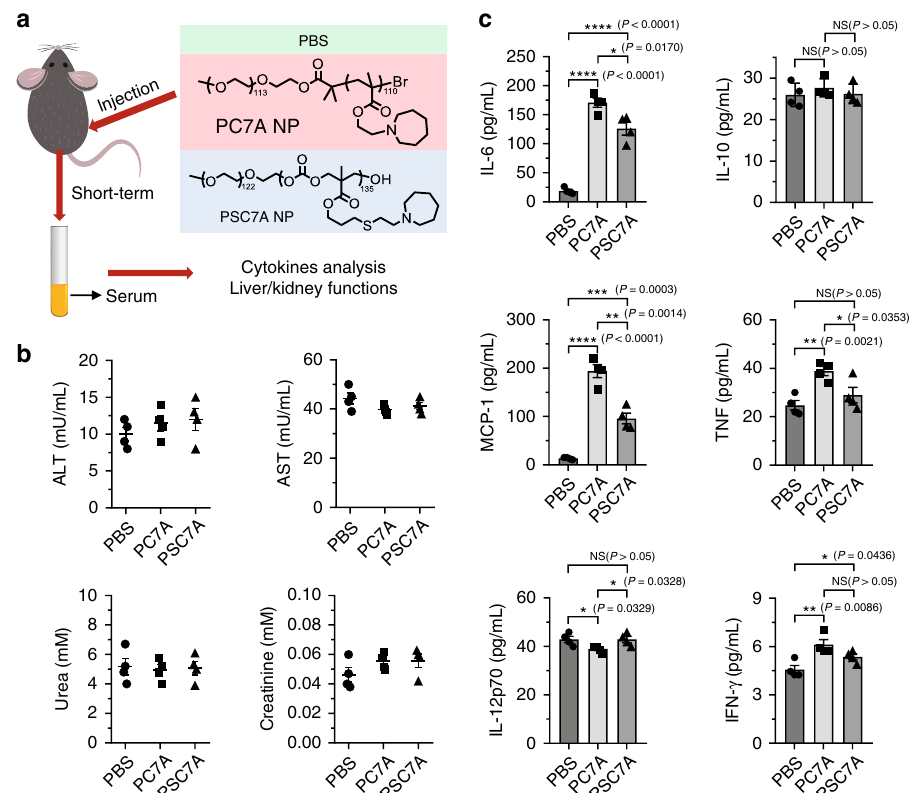
Fig. 6 Short-term safety evaluation of degradable PSC7A NP and non-degradable PC7A NP. a C57BL/6 mice were subcutaneously injected with PBS, 300 μ g PSC7A NP, or 300 μ g PC7A NP on the right fl ank. b Serum concentrations of alanine aminotransferase (ALT), aspartate aminotransferase (AST), urea, and creatinine levels were quantitatively measured by Abcam TM Assay Kit 24h after injection. n = 4 biologically independent mouse samples in each group. Data are presented as means± s.e.m. c Serum concentrations of interleukin-6 (IL-6), interleukin-10 (IL-10), monocyte chemoattractant protein-1 (MCP-1), interferon- γ (IFN- γ ), tumor necrosis factor (TNF), and interleukin-12p70 (IL-12p70) protein levels were quantitatively measured by BD TM CBA Mouse In fl ammation Kit 24 h after injection. n = 4 biologically independent mouse samples in each group. Data are presented as means ± s.e.m. and statistical signi fi cance was calculated using Student ’ s two-tailed t test ( **** P < 0.0001, *** P < 0.001, ** P < 0.01, * P < 0.05) and the exact P values are indicated in the fi